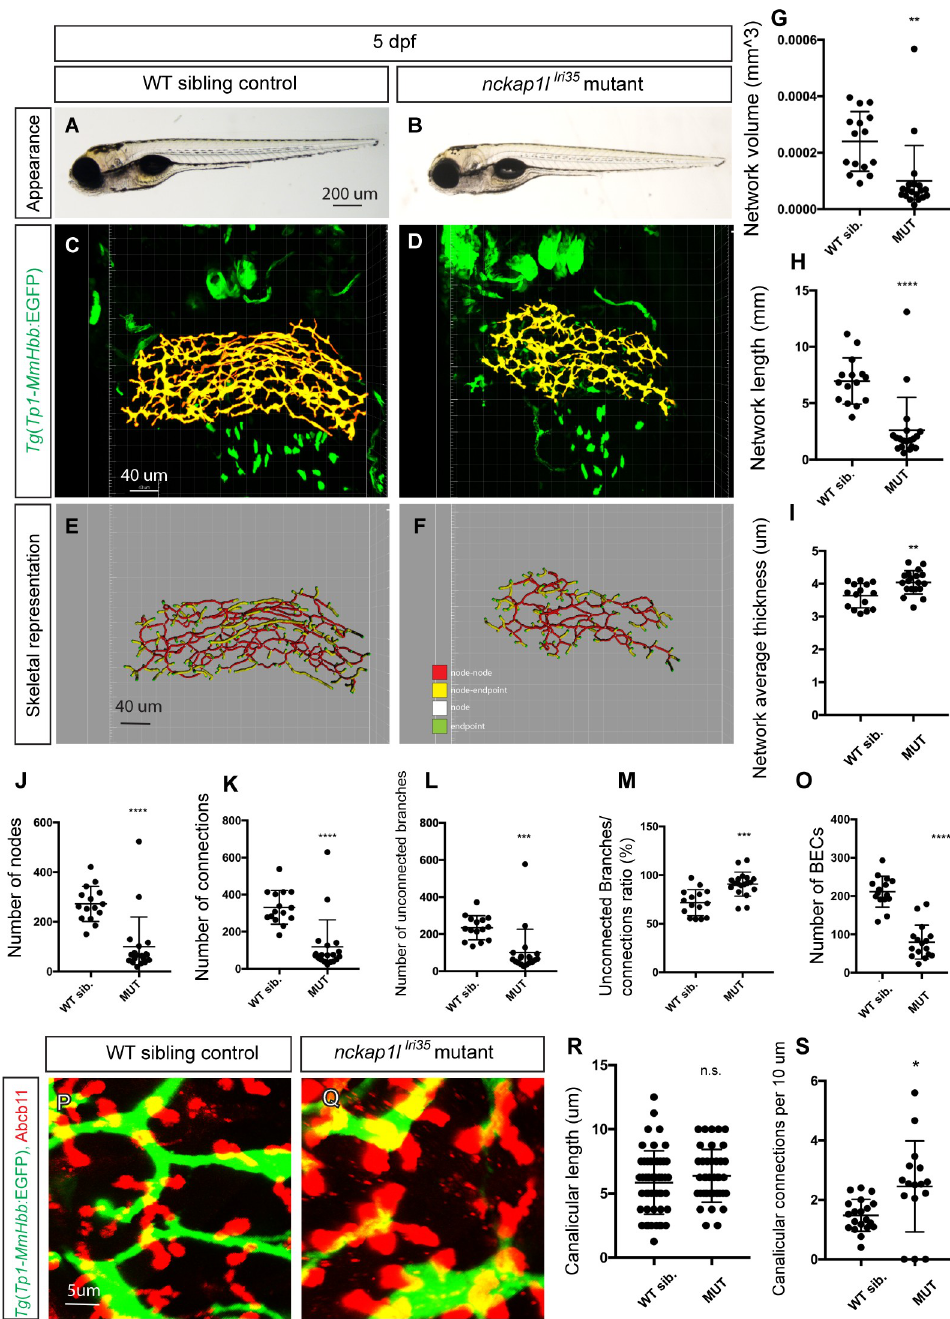
Fig 1. nckap1l lri35 mutant larvae show specific defects in the intrahepatic biliary network. (A and B) Representative physical appearance of wild-type (WT) sibling (A) and nckap1l lri35 mutant (B) larvae at 5 days post-fertilization (dpf). Lateral views. At 5 dpf, there is no significant difference in physical appearance in nckap1l lri35 mutant larvae, although their swim bladder inflation is occasionally delayed. (C and D) Projected confocal images of Tg(Tp1-MmHbb : EGFP ) um14 expression in WT (C) and nckap1l lri35 mutant (D) larvae at 5 dpf. GFP expression in the intrahepatic biliary network is shown in pseudocolored yellow. Ventral views, anterior to the top. (E and F) Skeletal representation of the intrahepatic biliary network in WT (E) and nckap1l lri35 mutant (F) larvae computed based on Tg(Tp1-MmHbb : EGFP ) um14 expression at 5 dpf. The complex three-dimensional network is represented by a combination of four segments: end points (colored green), nodes (colored white), node-node connections (colored red), and node-end point connections (colored yellow). (G-M) Computational skeletal analysis-based measurements of the intrahepatic biliary network structures of WT and nckap1l lri35 mutant larvae at 5 dpf. (G) The total network volume of the